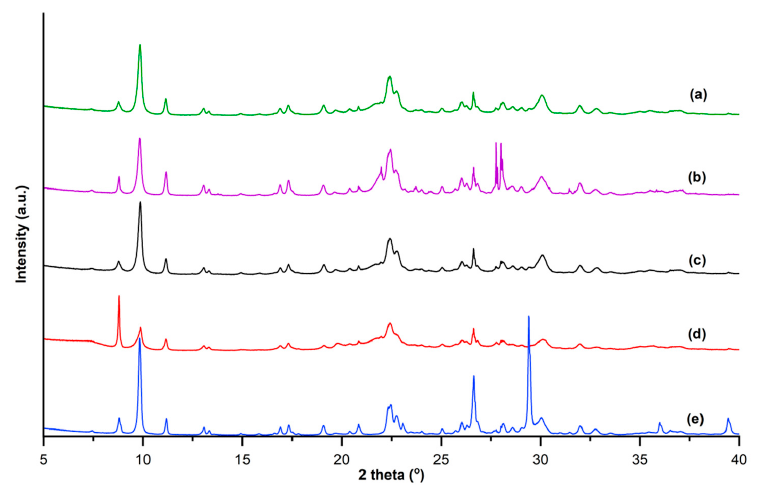
Figure 2. The pXRD patterns of ( a ) S1, ( b ) S2, ( c ) P1, ( d ) P2, and ( e ) P3 zeolites.